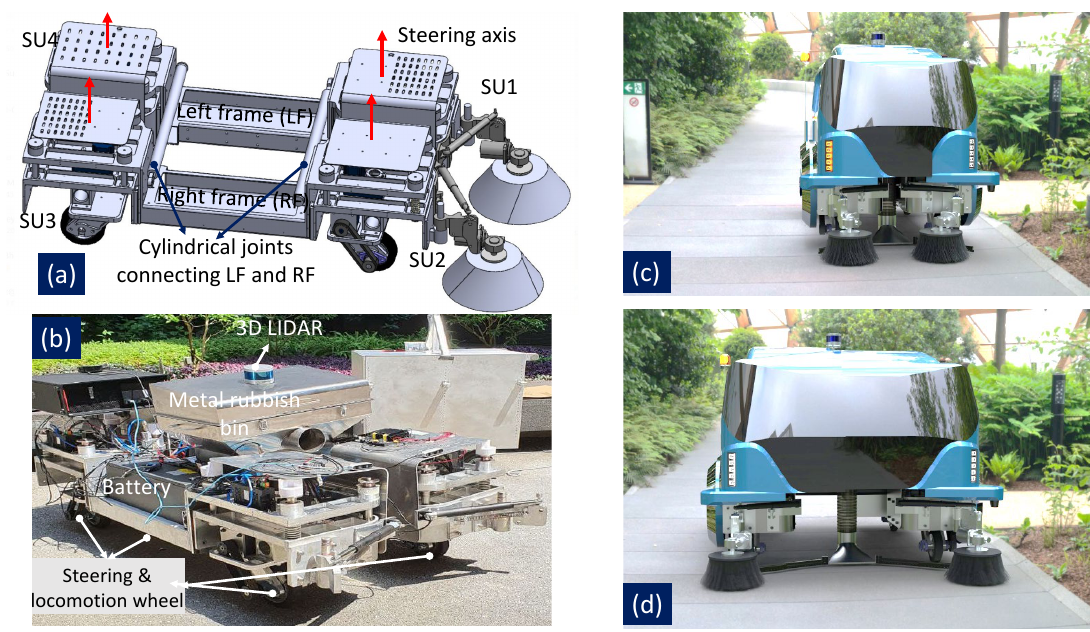
Figure 2. Design or reconfigurable robot Panthera ( a ) Chassis, steering units (SU), and cylindrical joints connecting the left frame (LF) to the right frame (RF), ( b ) Skeleton of the robot on pavement, ( c ) Fully compressed state of the robot with width 0.9 m, and ( d ) Fully expanded state of the robot with width 1.3